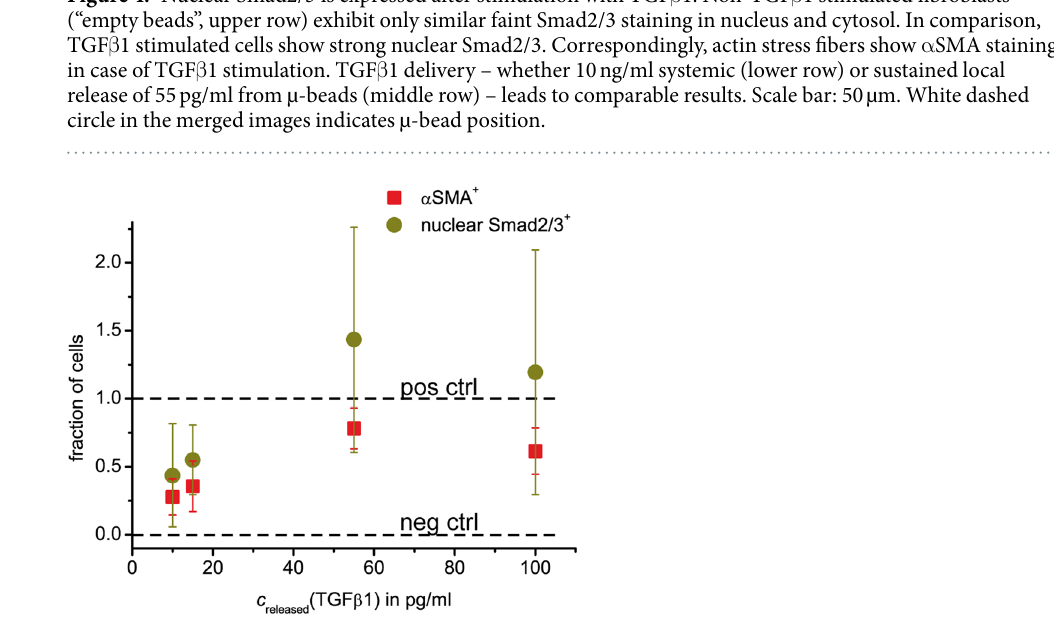
inside the µ -beads 10, 24 . The first feature imitates the continuous production of TGF β 1 by neighboring cells, while the second feature mimics functions of in vivo ECM 25 . Both functional properties together permit the delivery of small amounts of TGF β 1 in its biologically active form, persistent over time periods of several days, exactly mimicking the in vivo situation of constant paracrine TGF β 1 secretion by neighboring cells 5 .